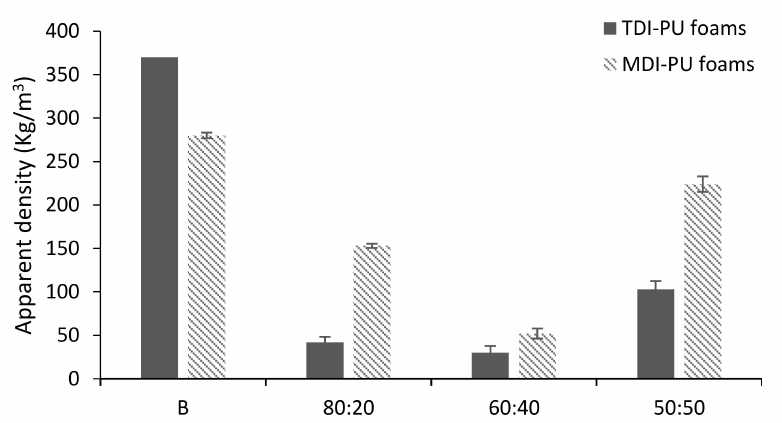
Figure 1. Apparent density of wheat straw liquefaction (LWS)-formulated polyurethane (PU)